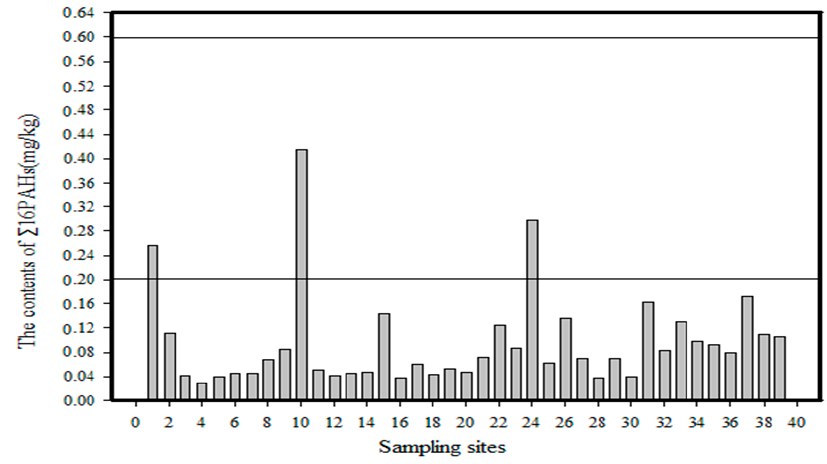
Figure 10. Degree of PAH contamination of the soil in Momoge Wetland.